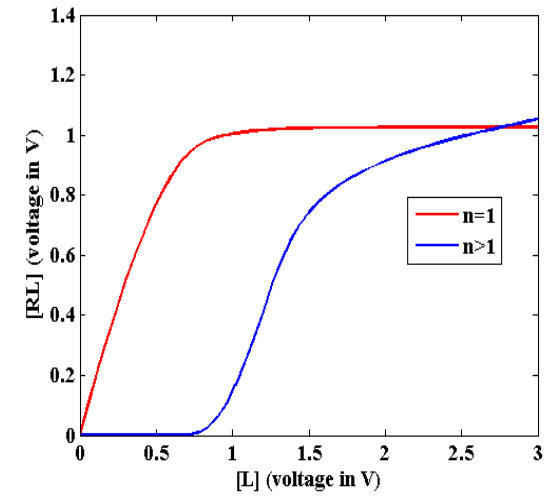
Fig.5: Graphical results for Hill Process obtained from cadence simulation of Electronic Circuit shown In Fig. 2, illustrating the effect of increasing binding sites on a receptor When there are more than one binding sites, the production rate is measured at drain current of M n being 2, 3 and 4, values taken for R and 4 K Ω respectively, and values for (cid:3) 550nm and 350nm respectively. The